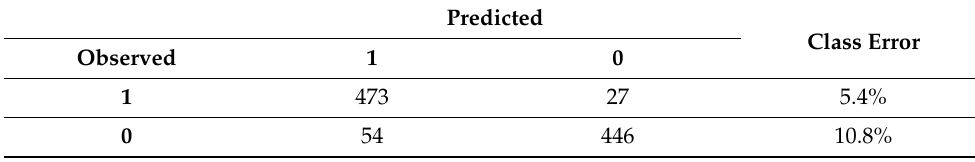
Figure 5. Processed high-resolution aeromagnetic layer for the Tarmoola area overlain by the pre- dicted results via the SRF classifier. The blue colour represents the areas predicted as the positive class whereas the red colour represents the areas predicted as the negative class. The yellow marker shows the point location of the main deposit, with a yellow outline giving the approximate envelope of the mineralised ferricrete unit. Table 3. Confusion matrix for the SRF classifier—Tarmoola area .